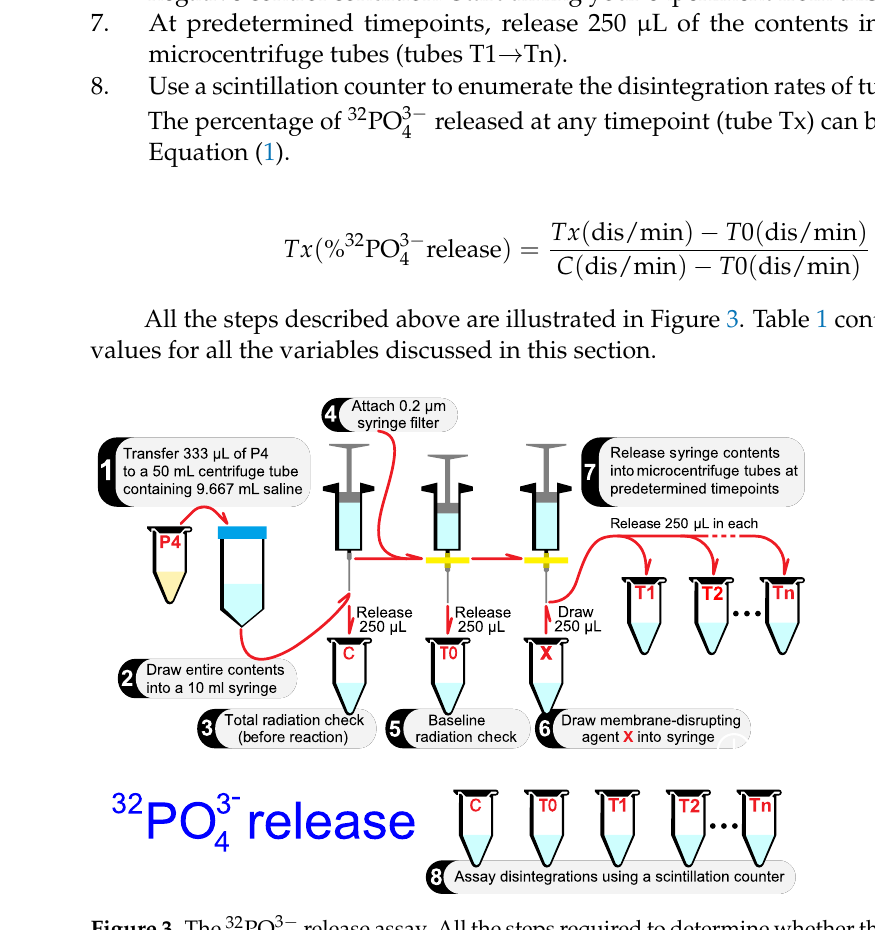
Figure 3. The 32 PO 3 − 4 release assay. All the steps required to determine whether the chosen membrane- disrupting agent (agent X) disrupts membranes leading to the release of cytoplasmic small molecules, tracked using 32 PO 3 − 4